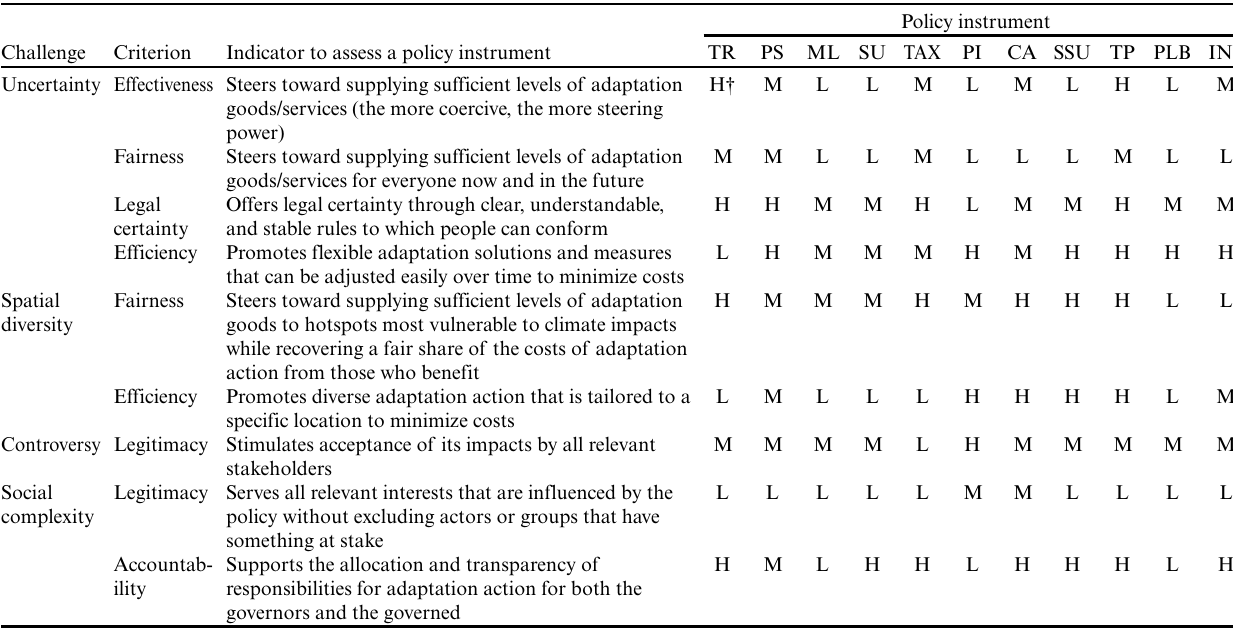
Table 3. General assessment of 11 policy instruments. See Table 1 for policy instruments and Table 2 for performance